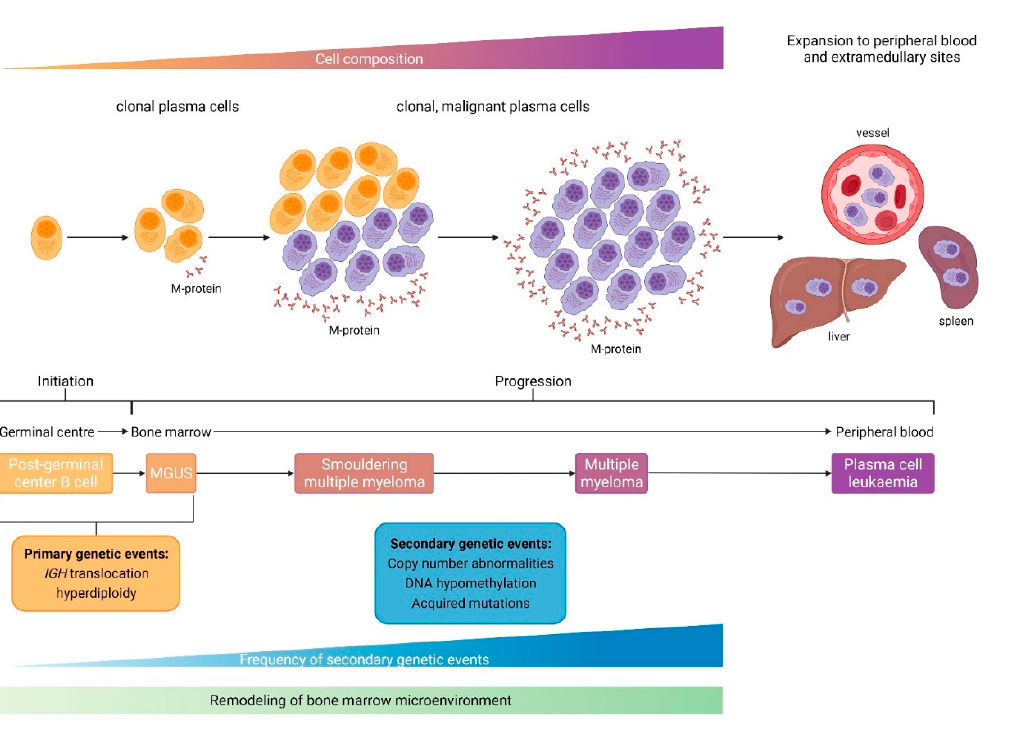
Figure 1. The development process of monoclonal gammopathies. Multiple myeloma arises as a result of complex and multistep changes in the bone marrow and is preceded by precursor states such as monoclonal gammopathy of undetermined significance (MGUS) and smoldering multiple myeloma (SMM). Adapted from Kumar et al. [1]. Created with BioRender.com (accessed on 30 June